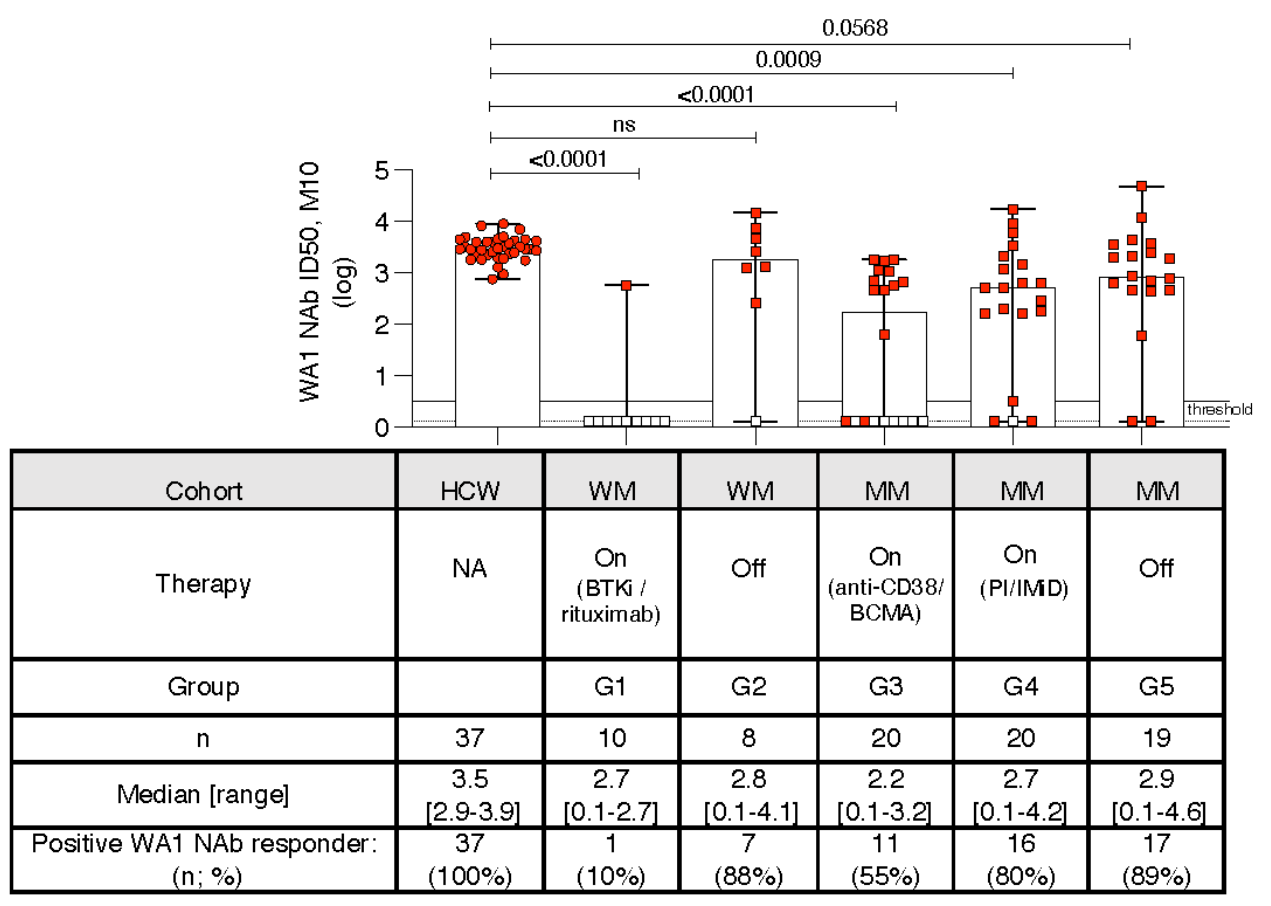
Figure 4. Breadth of NAb in HCW and patient cohorts. Neutralization was performed with a functional test using a pseudotype HIV NL ∆ Env-Nanoluc assay [30,31] carrying WA1 (D614G) Spike and the 50% Inhibitory Dose (ID50) was determined as described [12,26,27]. Data are shown for the HCW and the WM and MM patient cohorts after the 3rd dose at month 10. Box plot and whiskers (range) are shown. The threshold of quantification (0.5 log; solid line; considered negative) and the threshold of detection (0.1 log, dotted line) are indicated. Open square symbols denote samples with Spike-RBD titers <3000, which were not tested but predicted to be negative and were entered as 0.1. The number of samples tested, median and range of responses, and the number and % of positive responders are given. The p values are from ANOVA (Friedman test) for the comparisons to the HCW NAb responses. ns—no significant difference.